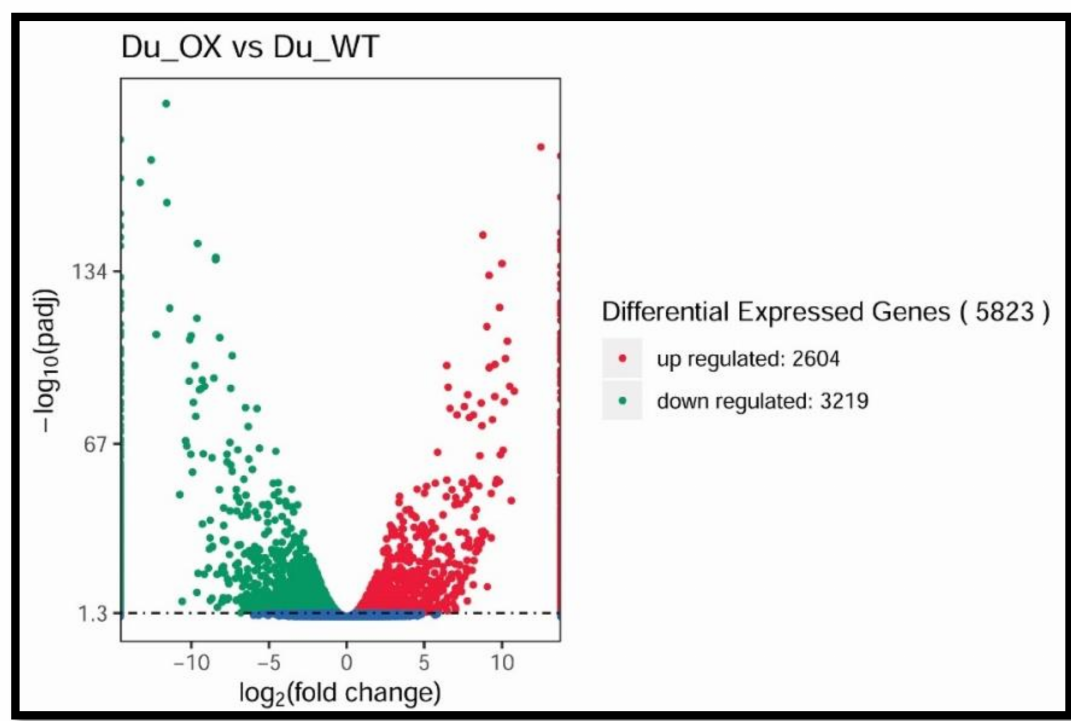
Figure 5. Differentially expressed genes of DU-OE as compared with DU-WT (including up-regulated and down-regulated